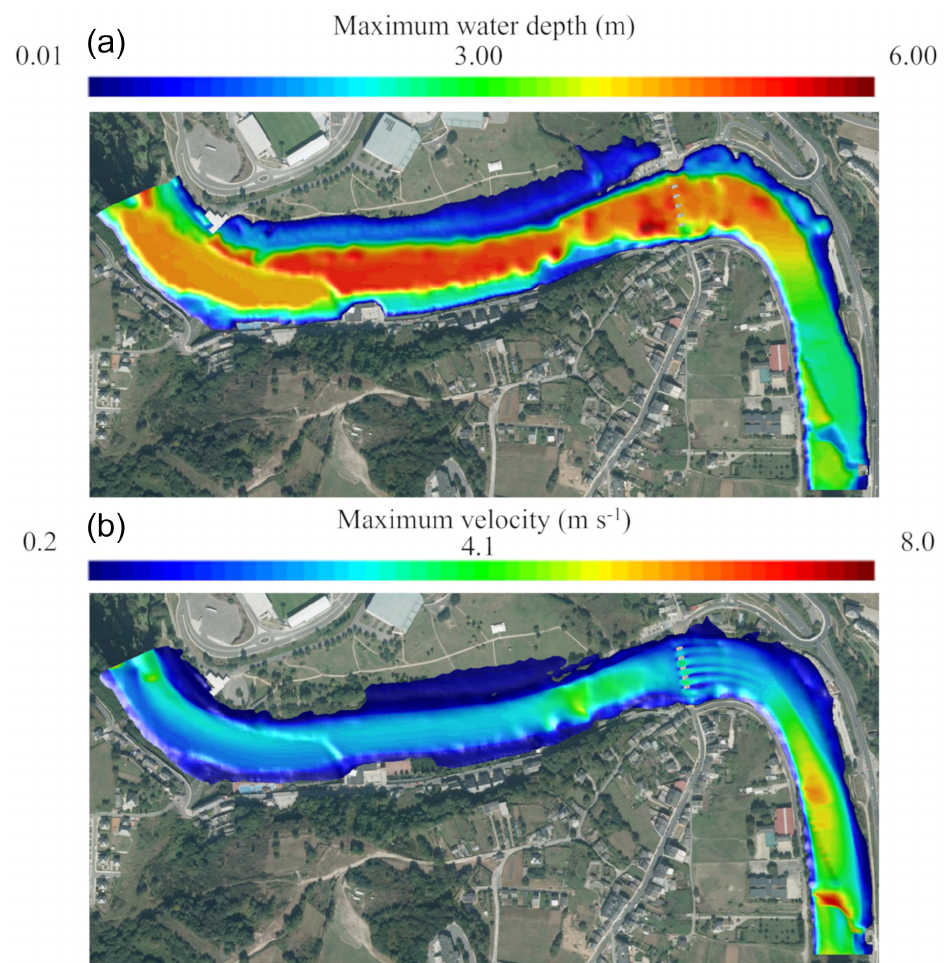
Figure 8. Maximum water depth (a) and maximum velocity (b) obtained with Iber + for the 1d precipitation forecast (PNOA courtesy of © Instituto Geográfico Nacional).